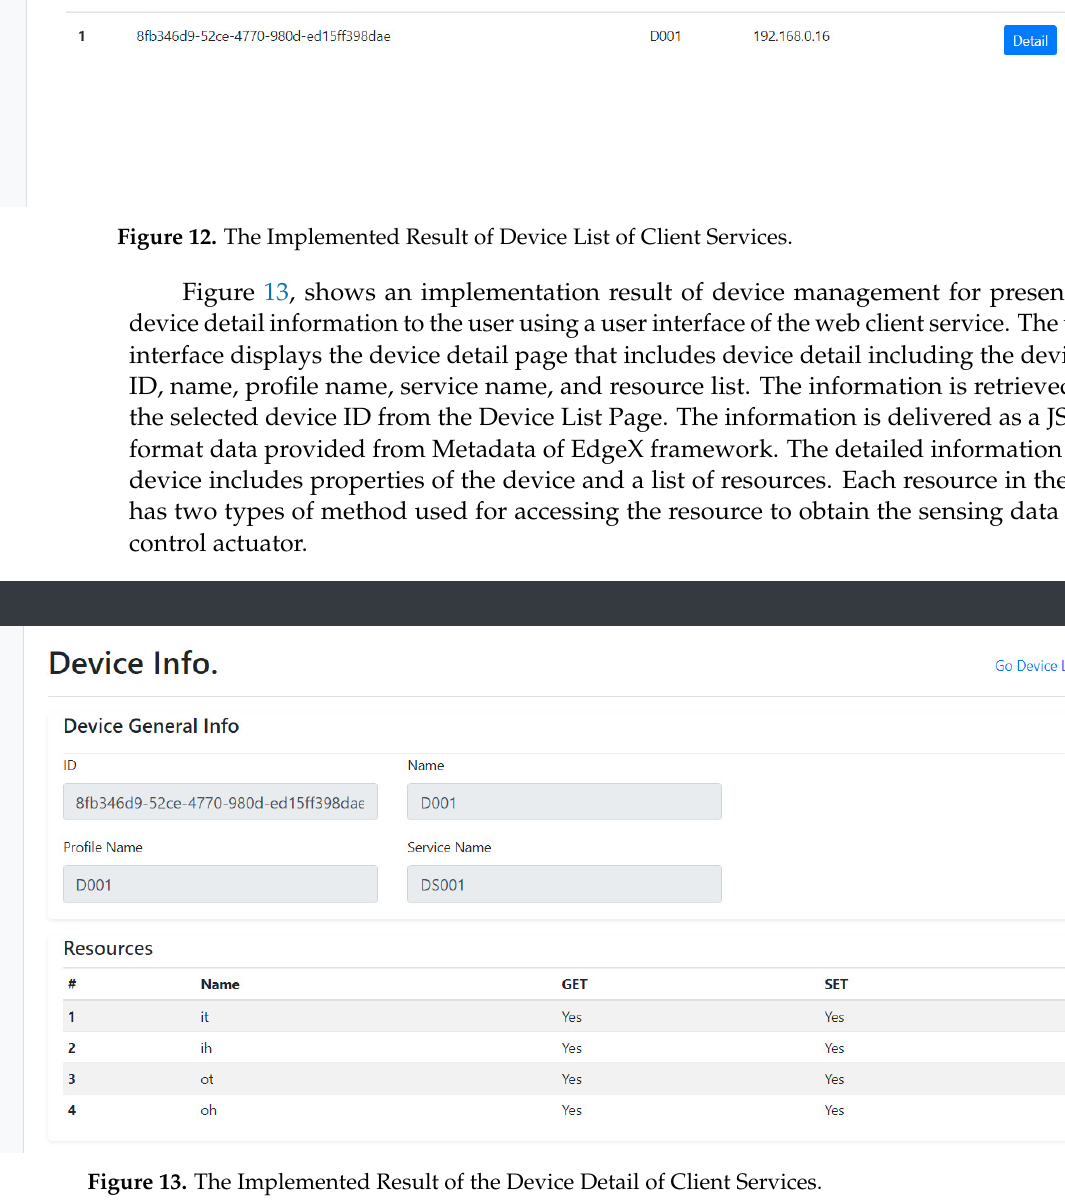
Figure 13. The Implemented Result of the Device Detail of Client